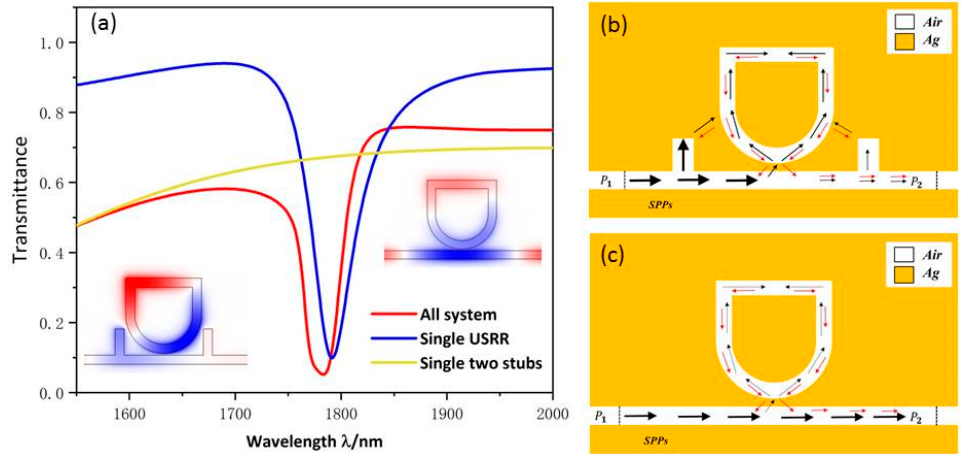
Figure 2. ( a ) Transmittance spectra of the single two baffles (yellow line), single USRR resonant cavity (blue line), and all system (red line); ( b ) The SPP pathway schematic of the system; ( c ) The SPP pathway schematic of the single USRR structure.